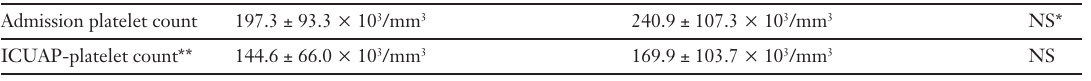
Platelet counts in ICUAP caused by gram-negative and gram-positive mi- croorganisms in 36 patients with ICUAP caused by a single